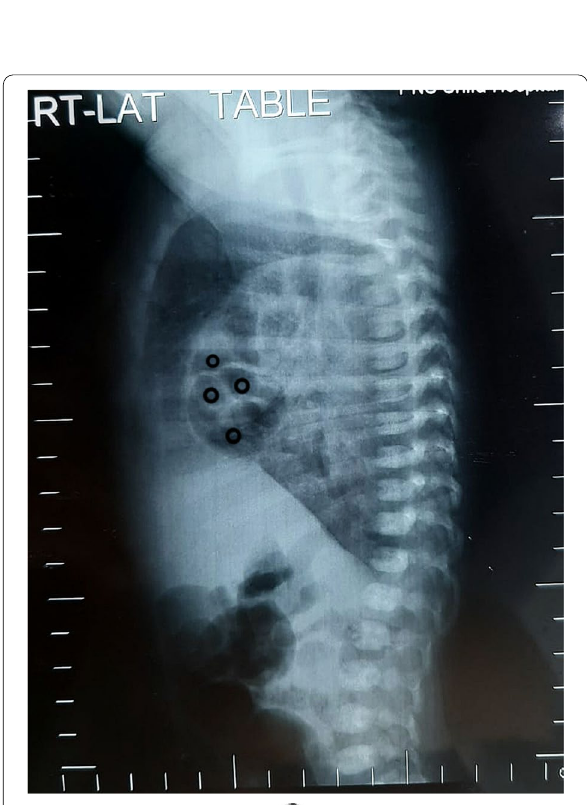
Fig. 2 Babygram in lateral view: Cystic lucencies in right hemithorax to be in continuation with the right abdominal